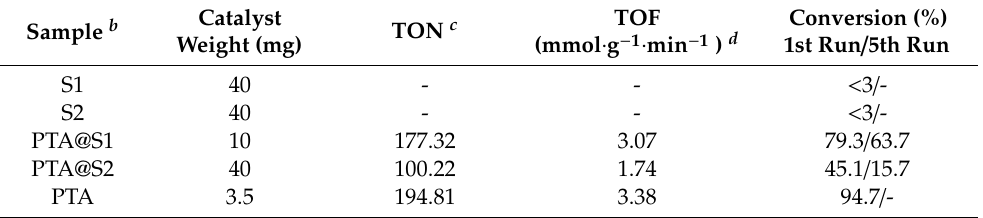
Table 2. Summary of catalytic reactions of the ring opening of styrene oxide with methanol a . Sample b